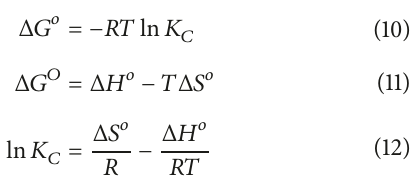
) and external mass transfer i